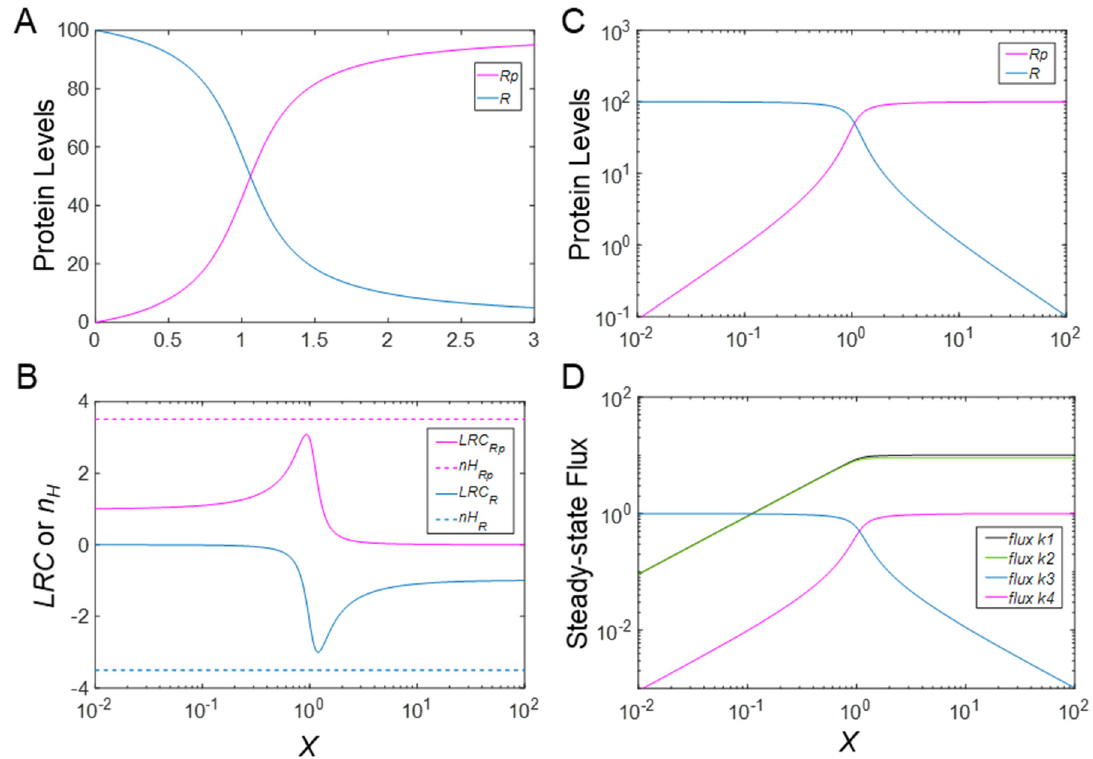
Figure 2. Steady − state does − response (DR) curves of R and R p , associated fluxes, n H and LCR , as functions of kinase X activity in the MM model. ( A ) DR curves of R vs. X and R p vs. X on linear scale. ( B ) n H and LRC of DR curves of R vs. X and R p vs. X . ( C ) DR curves of R vs. X and R p vs. X in a log-log representation. ( D ) Fluxes, named by associated rate constant, plotted against X . Specifically, flux k 1 : phosphorylation; flux k 2 : dephosphorylation; flux k 3 : degradation of R ; and flux k 4 : degradation of R p .